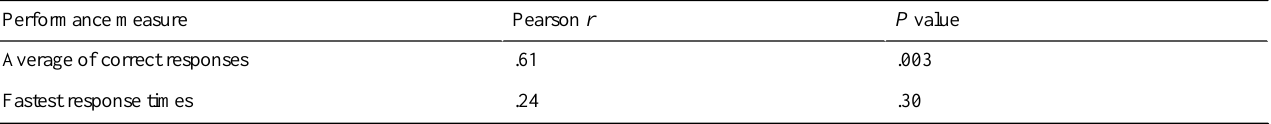
Table 1. Correlation analysis between performance measures in the Arrow test and the Spotter